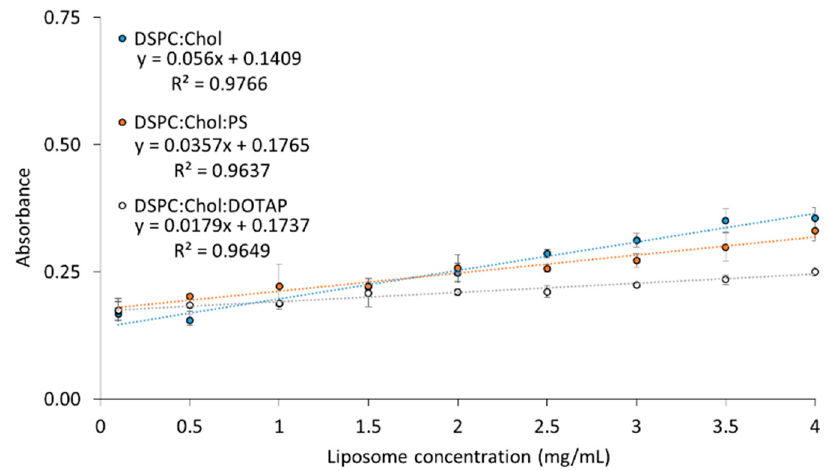
Figure 2. The effect of increasing liposome concentration on micro BCA absorbance with no ovalbumin added. Three liposomal formulations were produced using microfluidics (FRR 3:1 and 1:1, TFR 10 mL/min), DSPC:Chol, DSPC:Chol:PS and DSPC:Chol:DOTAP and assessed for BCA absorbance interference. Results represent the average of at least three replicate measurements ± standard deviation (SD).